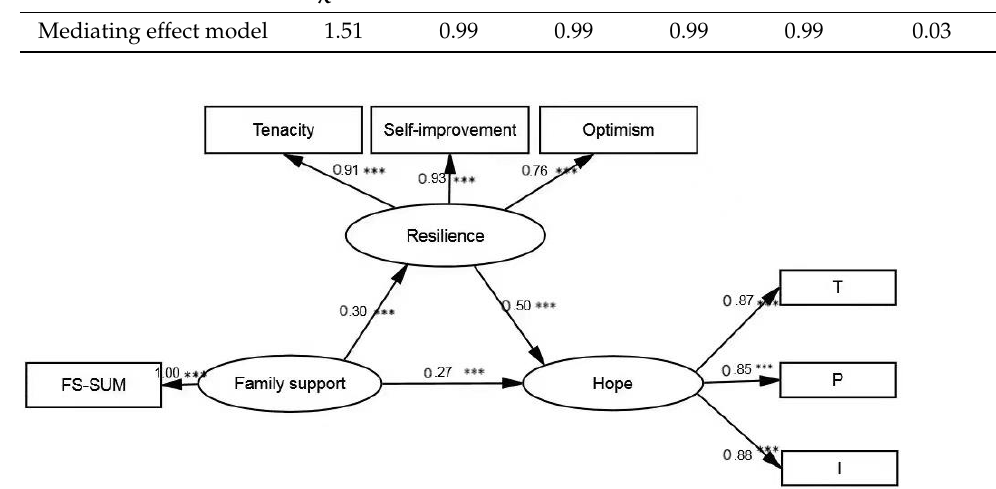
Figure 1. Results of the mediation analyses in PWSUD. *** p < 0.001. Table 4. The model fitting index of the influence of family support and resilience on the hope. χ 2 /df